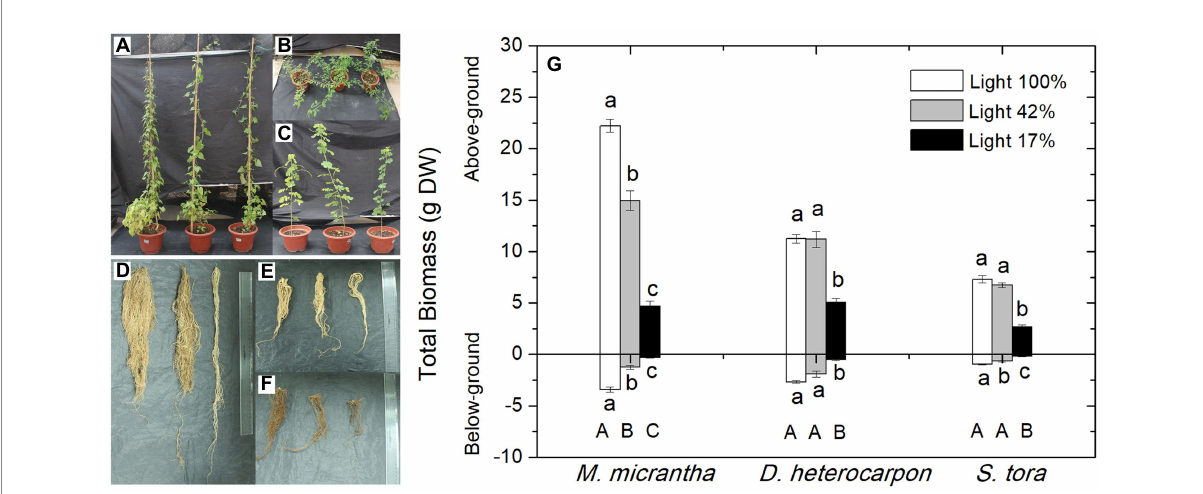
FIGURE 3 Changes of shoot phenotype, root phenotype and biomass of two replacement forage legumes and M. micrantha under different light conditions. (A, D) Represent M. micrantha ; (B, E) Represent D. heterocarpon ; (C, F) represent S. tora . The treatments of each plant from left to right were light 100%, light 42% and light 17%, respectively. (G) The average values ± standard errors of five replicates were shown. The lowercase letters above bar plots represent the difference in the above-ground biomass of each plant under different light treatments. The lowercase below bar plots represent the difference in the below-ground biomass of each plant, and the capital letters below bar plots represent the difference in the total biomass (Duncan test, p <